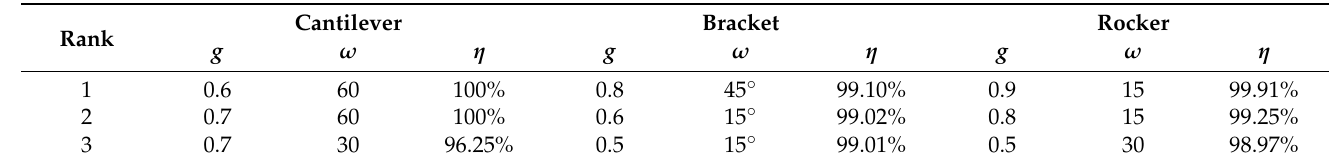
Table 2. Overall summary of the results for all three application examples. For each example, the best three configurations are shown with their corresponding η